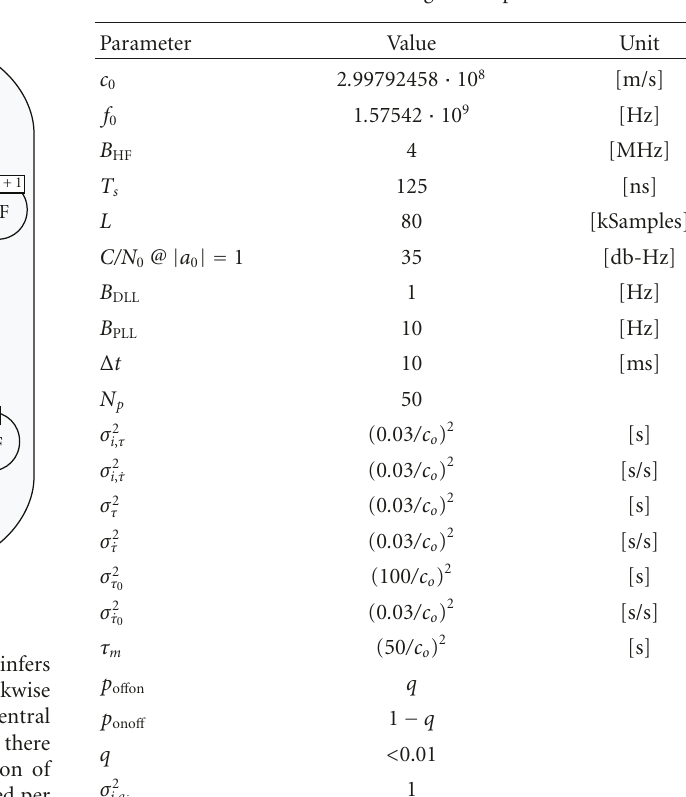
Table 1: Simulation and algorithm